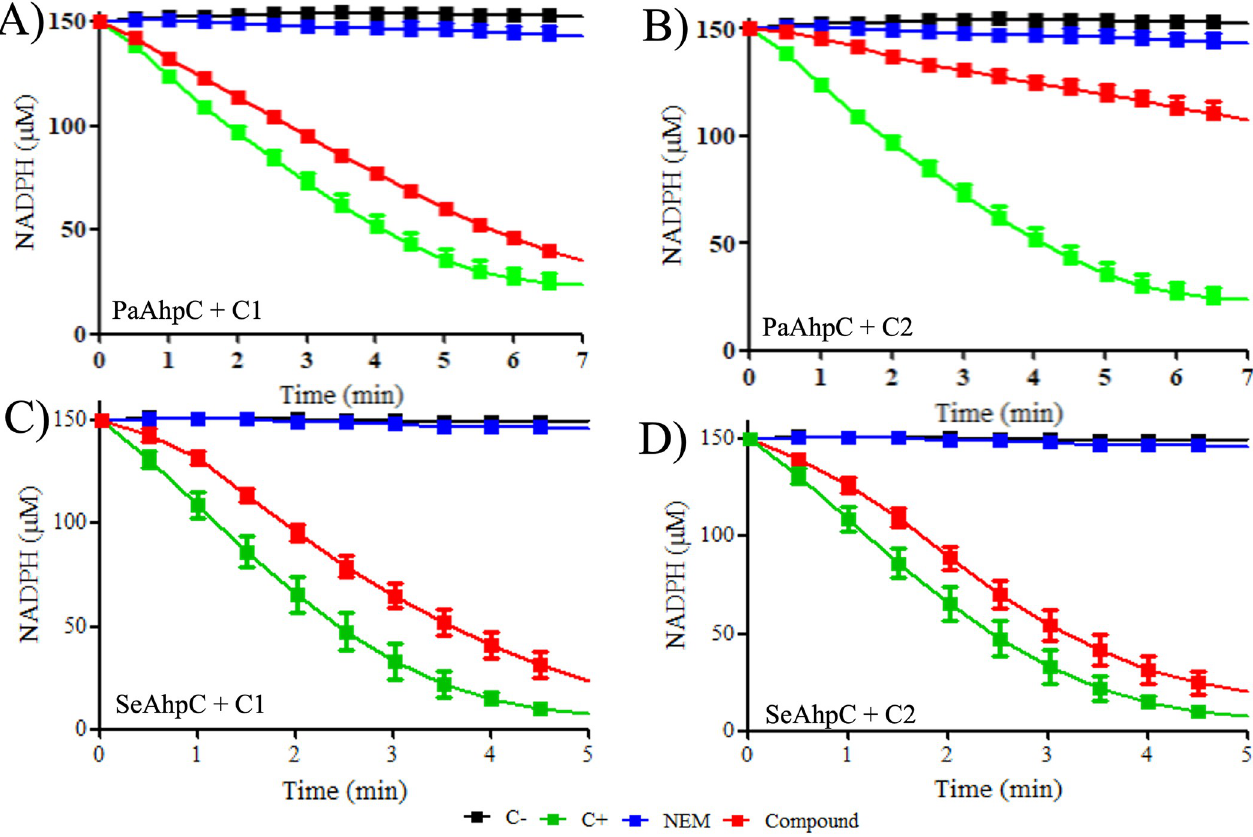
Fig 3. NADPH oxidation assay of PaAhpC and SeAhpC after treatment with compounds C1 and C2. To perform the assays PaAhpC and SeAhpC samples were previously reduced with DTT (5 mM/1h). The DTT excess was removed, and the enzymes were treated with 40 molar equivalents of C1 ( A and C , red square) or C2 ( B and D , red square) for 1hour at room temperature. The compounds excess was removed, and the peroxidase activity was accessed by the NADPH oxidation in reactions containing: 3 μ M of PaAhpC or SeAhpC, 6 μ M EcTrx, 0.9 μ M EcTrxR and 150 μ M NADPH in buffer 50 mM HEPES (pH = 7.4), 100 μ M DTPA and 1 mM sodium azide. Reactions were incubated at 37˚C for 5 minutes before being initiated by the addition of H 2 O 2 (500 μ M) and monitored spectrophotometrically at 340 nm, 37˚C, for 5 minutes. Reactions containing PaAhpC or SeAhpC without natural compounds treatment (green square) were used as positive controls for peroxidase activity, and reactions without AhpC (black square) were used as negative controls. PaAhpC or SeAhpC samples previously treated with NEM were used as control of protein inhibition (blue square). All experiments were performed at least three times in triplicate.